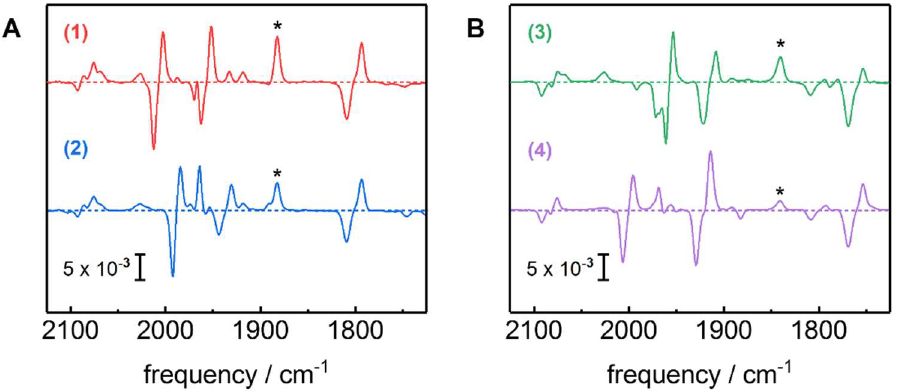
Figure 5. Hox-CO → Hred´-CO conversion for 13 CO isotopomers 1–4. The in situ ATR-FTIR difference spectra of the H-cluster show Hox-CO at − 200 mV (negative bands) and Hred´-CO at − 800 mV versus normal hydrogen electrode (NHE, positive bands). Panel ( A ) shows isotopomers 1 and 2 with a µ 12 CO ligand, while in ( B ) the bridging ligand is exchanged to 13 CO (isotopomers 3 and 4). * Bands due to Hsred populations.